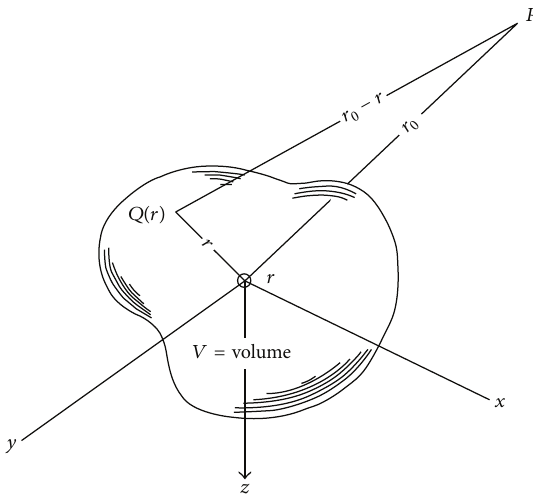
Figure 2: Magnetic scalar